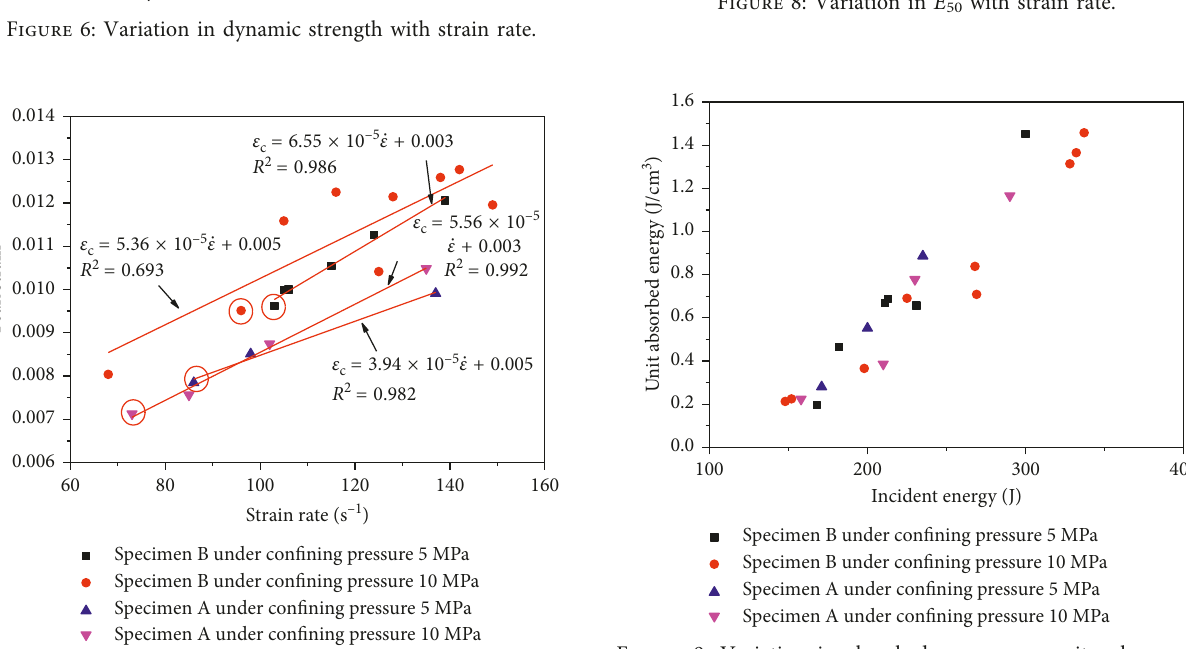
Figure 9: Variation in absorbed energy per unit volume with incident